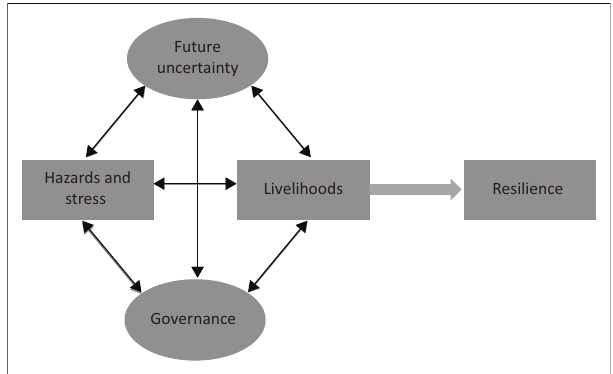
FIGURE 1: The vulnerability to resilience